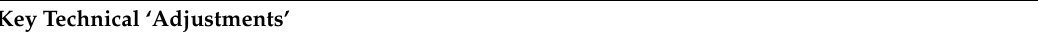
Table 1. Summary of technical ‘adjustments’ and ‘improvements’ implemented on